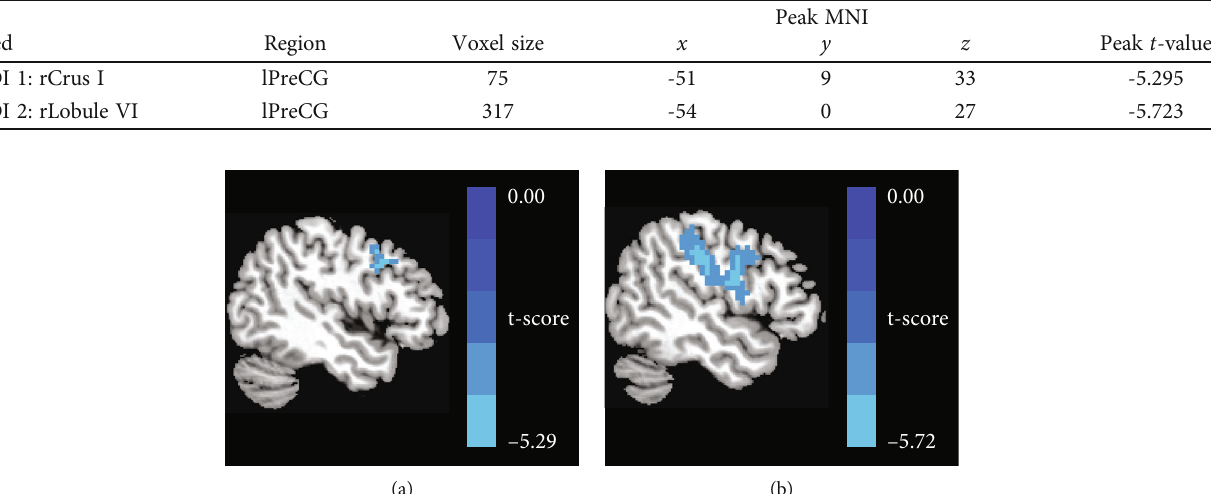
Table 4: Regions with signi fi cant between-group di ff erences in seed-based FC analysis (patient > control).